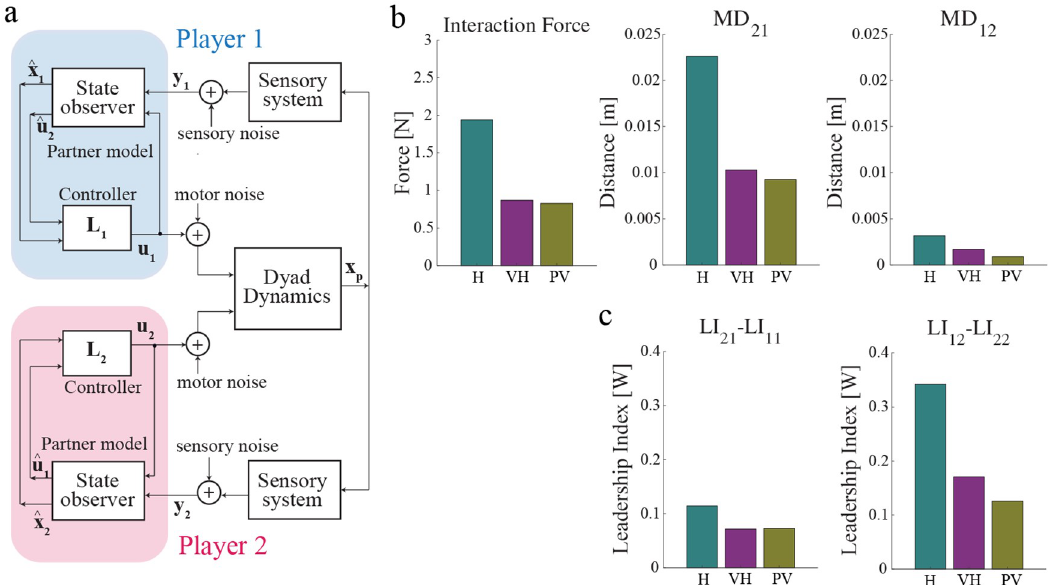
Fig 5. Computational model. (a) Two players jointly control dyad dynamics (approximated as two mass-points connected by a spring). Each player has a separate sensory system which provides information about dyad state. The controller includes a state observer, a feedback controller and an estimate of the partner’s control action (partner model). (b) From left to right: Interaction force and minimum distance from VP 1 ( MD 21 ) and VP 2 ( MD 12 ), for all three H, VH and PV scenarios. (c) Leadership index for player 1 and player 2 at VP 1 (left) and VP 2 (right) for all three H, VH and PV scenarios.